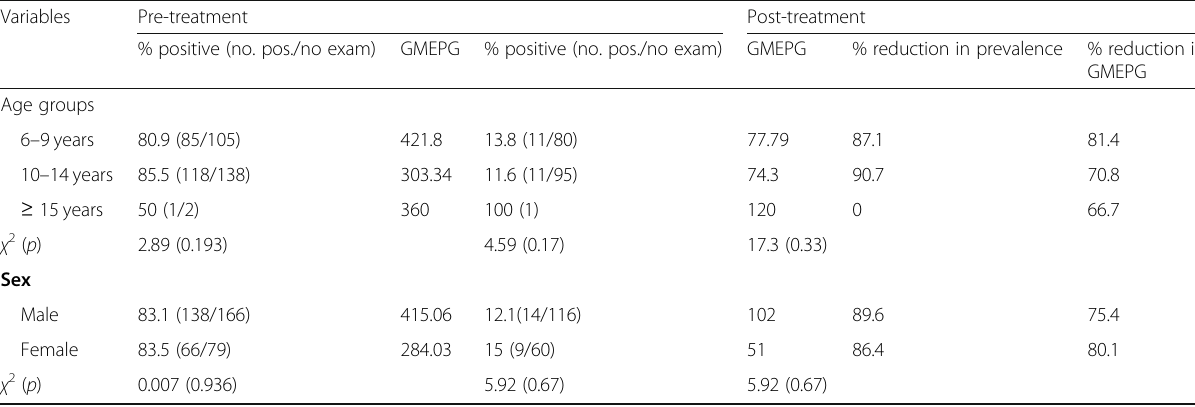
Table 1 Pre and post-treatment prevalence (%) and intensity (EPG) of S. mansoni infection among Sanja General Elementary school children, Northwest Ethiopia, 2017